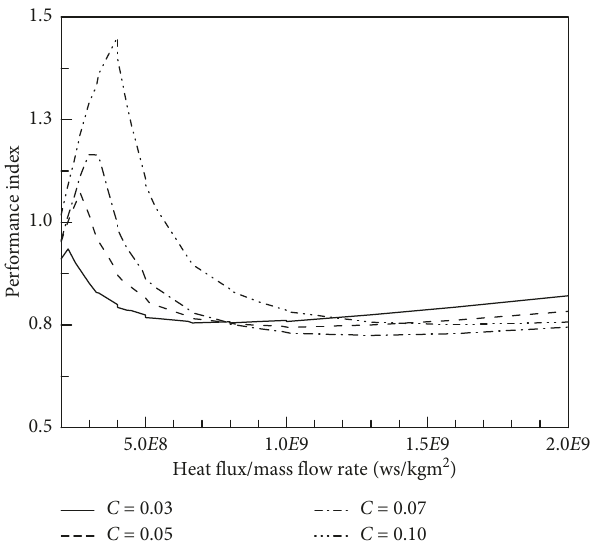
Figure 7: Effect of heat flux per unit mass flow rate on the per- formance index for various concentrations of lauric acid slurry